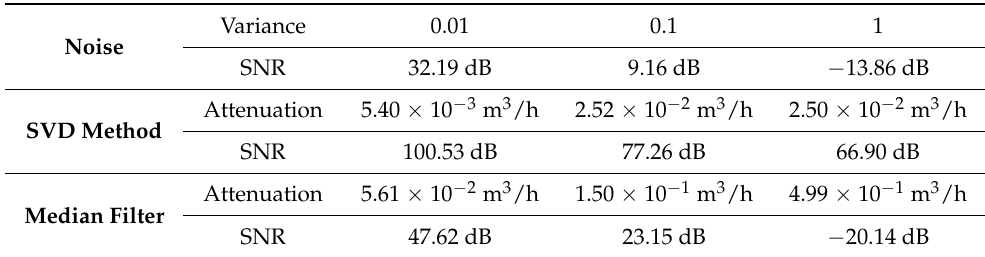
Table 1. Amplitude attenuation and SNR improvement for 1 Hz